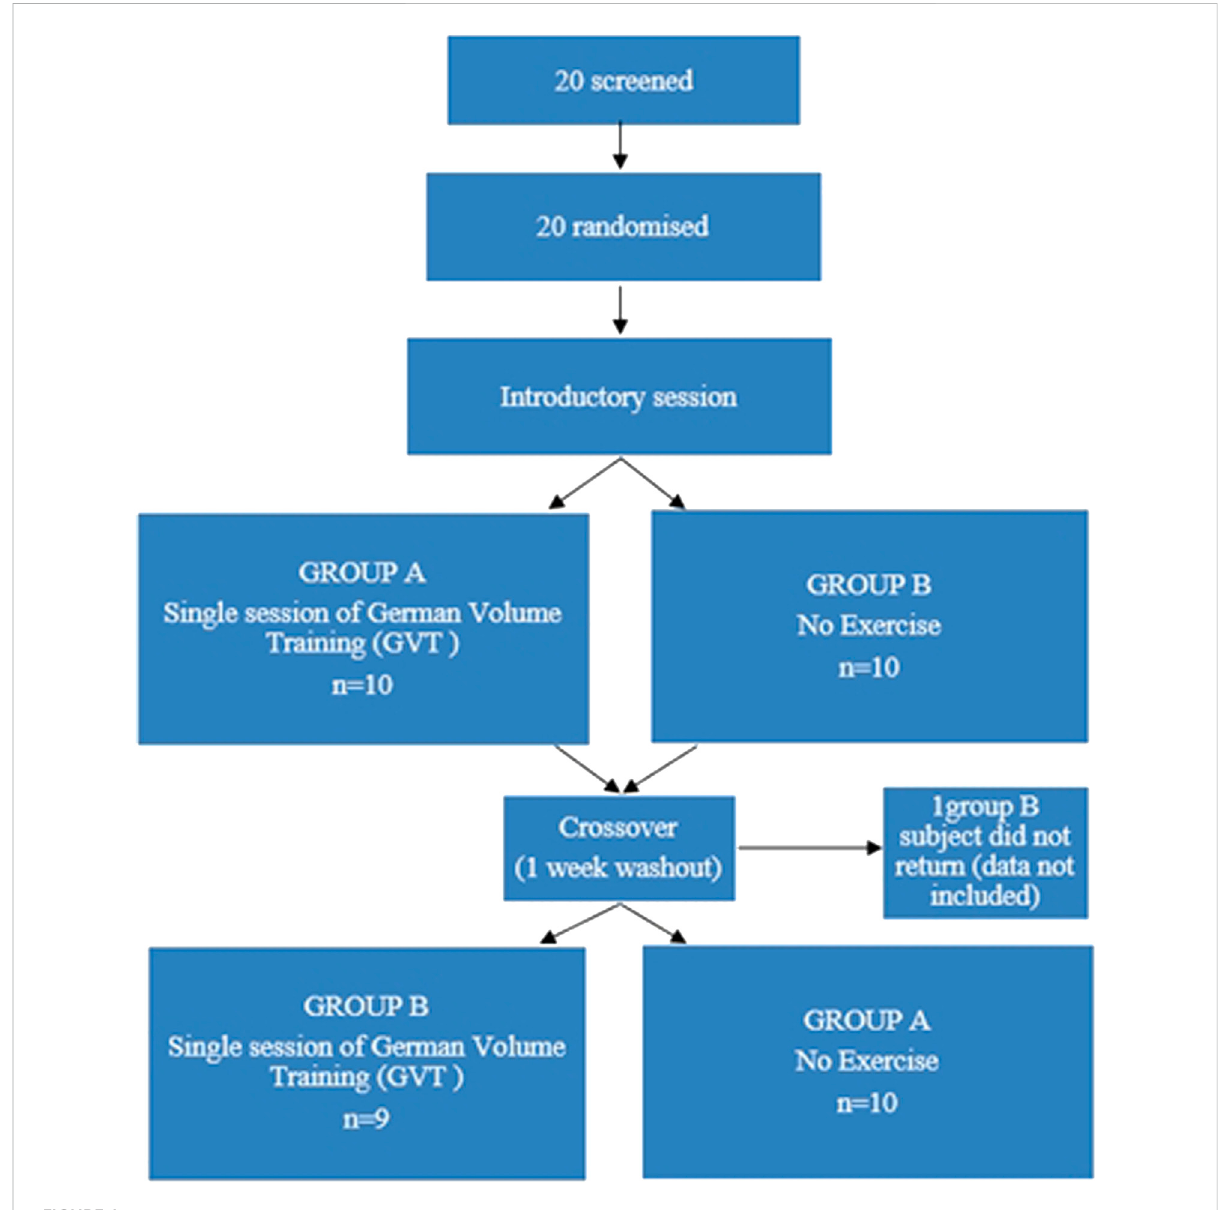
FIGURE 1 Design of randomized crossover study to examine the acute vasopressor, pulmonary and metabolic responses to German Volume Training (GVT).